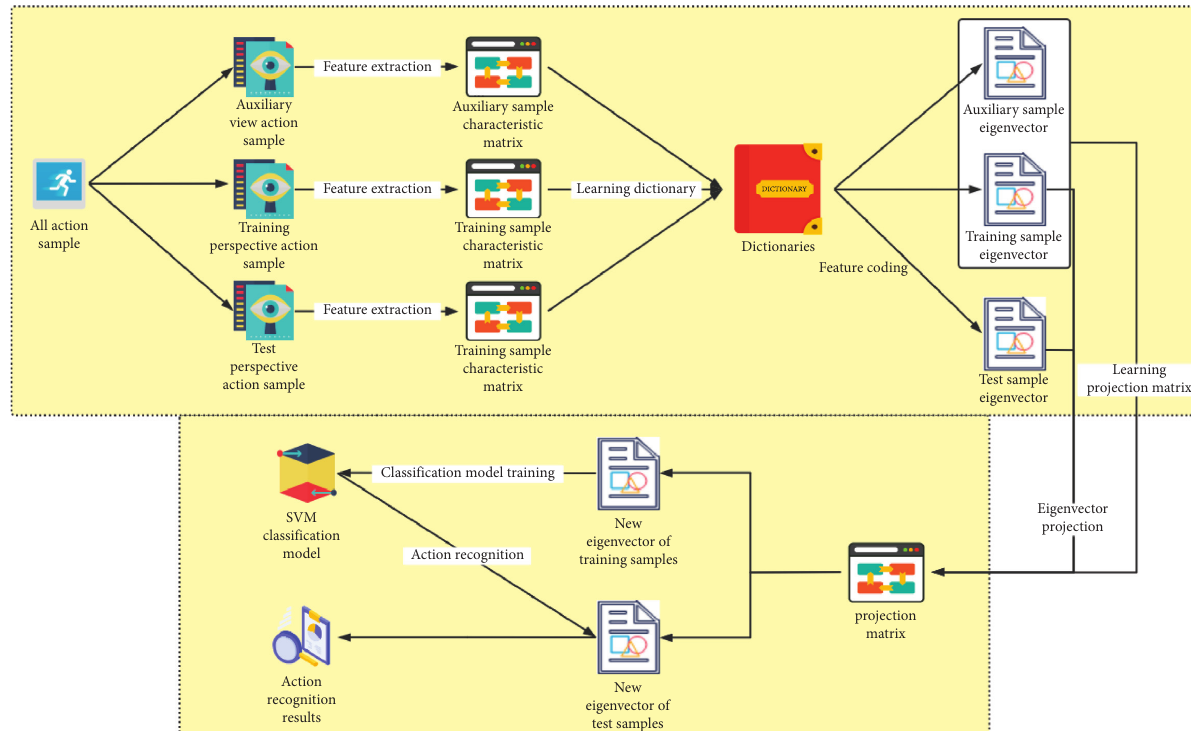
Figure 1: SVR model and multimedia technology training process action